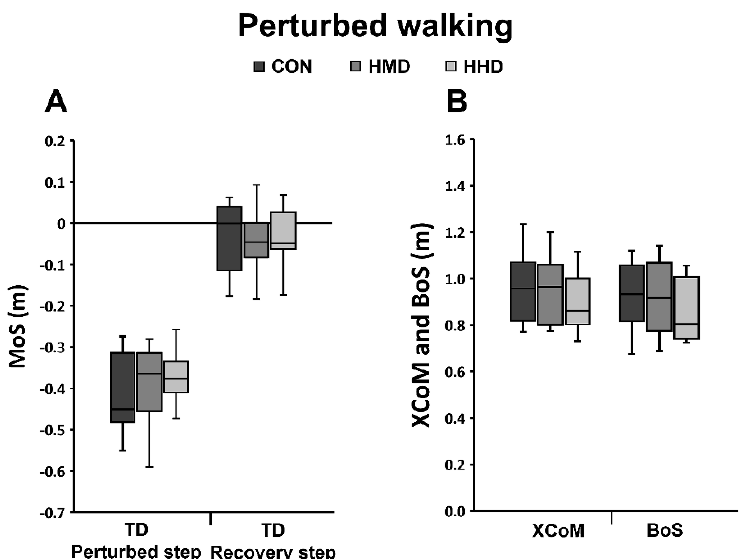
Figure 4. The margin of stability (MoS) and related stability components during unperturbed and perturbed walking illustrated with box plots (median, 1st and 3st quartile and whiskers) of all analysed participants for control condition (CON), head-mounted display (HMD) and hand-held display (HHD). ( A ) MoS at touchdown (TD) of the perturbed step and at touchdown of the first recovery step; ( B ) extrapolated centre of mass (XCoM) and base of support (BoS) at TD of the first recovery step.